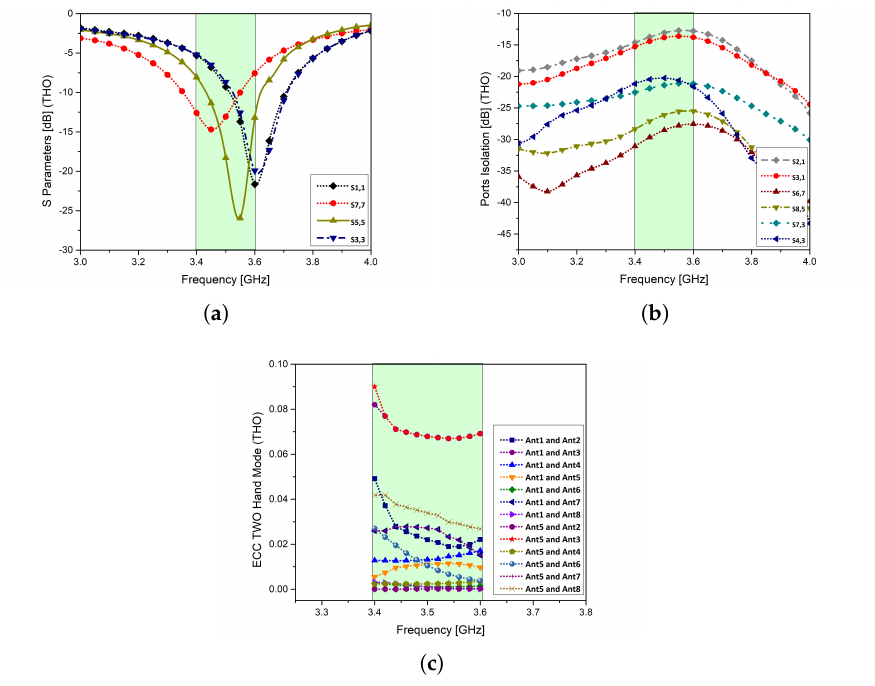
Figure 12. Performance parameters in two hand mode (THM): ( a ): S-parameters, ( b ): port isolation, ( c ): ECC.